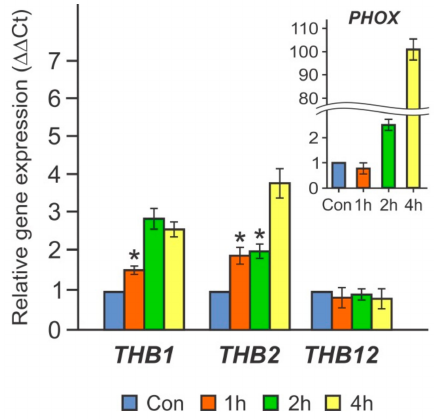
Figure 2. The e ff ects of short-term incubation in phosphorus-free medium (TA) on the relative transcript abundance of THB1 and THB2 in the cw15-325 strain. Levels of gene transcripts are calculated as times of relative abundance with respect to the housekeeping control gene ( RACK1 ), which has a value of 1. The figure inset shows the PHOX transcript accumulation. Data are the means ± SE from three biological and two technical replicates obtained by quantitative RT-PCR. Asterisks indicate the statistically significant di ff erences between the untreated and treated P-deprived cells (* P <